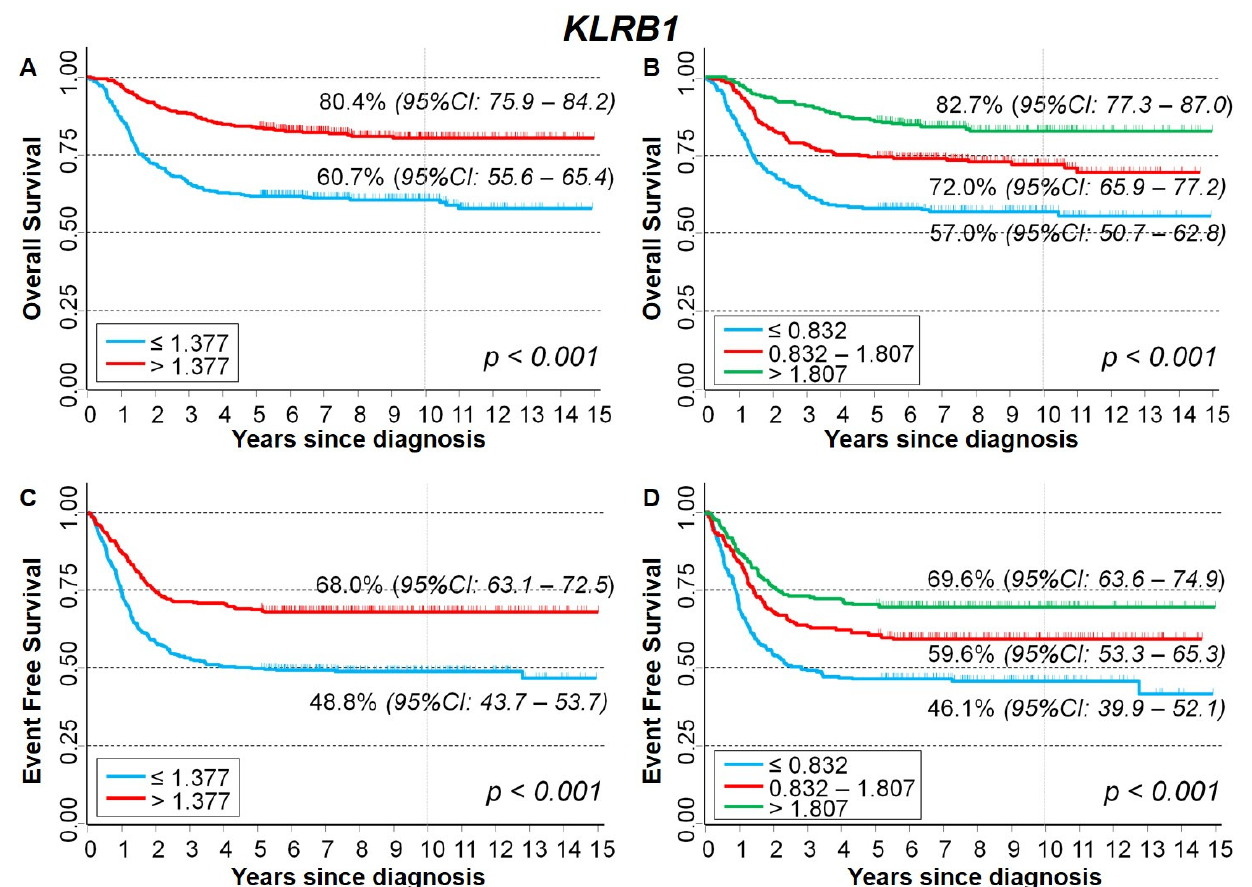
Figure 7. Kaplan–Meier survival curves of the whole cohort of 786 NB patients in relation to KLRB1 gene-expression values. ( A ) Overall survival, cut-off based on the median expression value; ( B ) Overall survival, cut-offs based on tertile expression values. ( C ) Event-free survival, cut-off based on the median expression value; ( D ) Event-free survival, cut-offs based on tertile expression values. Ten-year survival estimates are displayed. Table 3. Survival of the whole cohort of patients with NB in relation to KLRB1 gene-expression values, evaluated by the multivariable Cox regression model. Overall Survival Event Free Survival